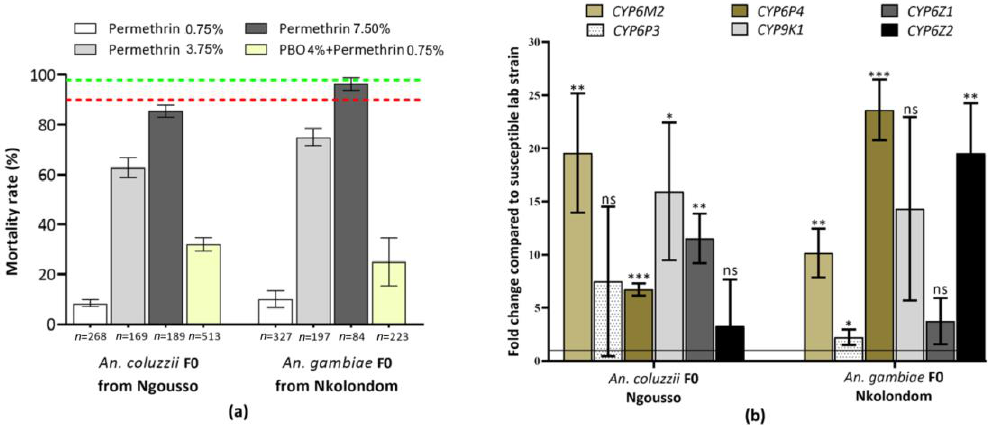
Figure 1. Resistance profile of An. coluzzii and An. gambiae to Permethrin. ( a ) Activities of PBO combined to permethrin on An. coluzzii from Ngousso and An. gambiae from Nkolondom, Cameroon. Data are shown as median ± SEM. ( b ) Differential expression of some metabolic resistance genes among the Ngousso and Nkolondom resistant mosquito populations as compared with Ngousso or Kisumu laboratory strain, respectively, to the species. Degree of significance of differential expression in comparison with susceptible strains: “***” < 0.0005 p -values, “**” < 0.005, “*” < 0.05, “ns”: